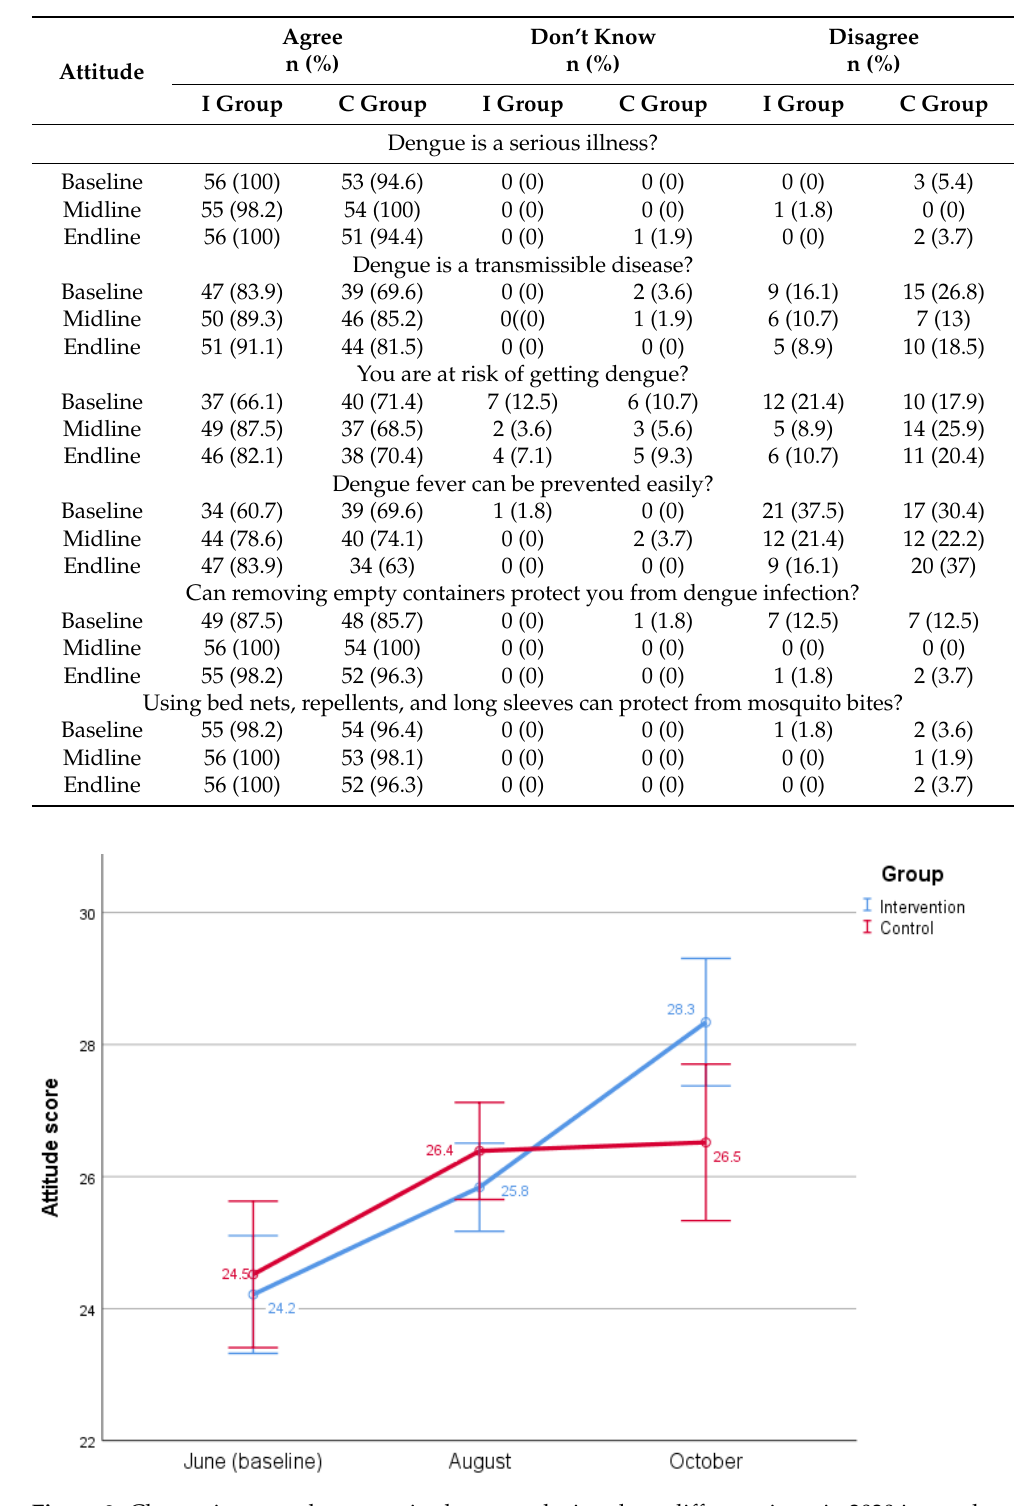
Table 5. Attitude towards dengue disease at the baseline, midline, and endline.